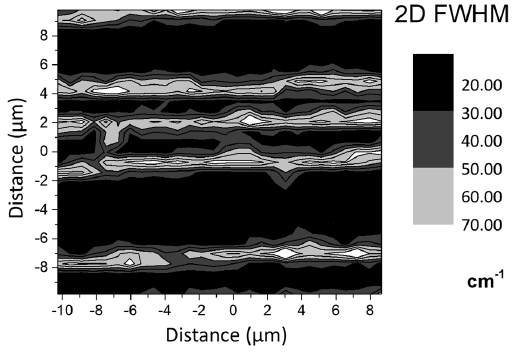
Figure 1. The spatial map of FWHM (Full Width at Half Maximum) of the 2D Raman mode. The FWHM within 20–30 cm − 1 shown by black color indicates single graphene layer.